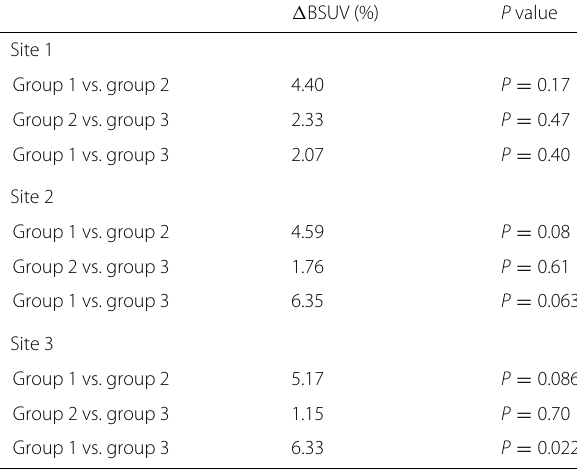
of this magnitude are unacceptable for multicenter trials [10,